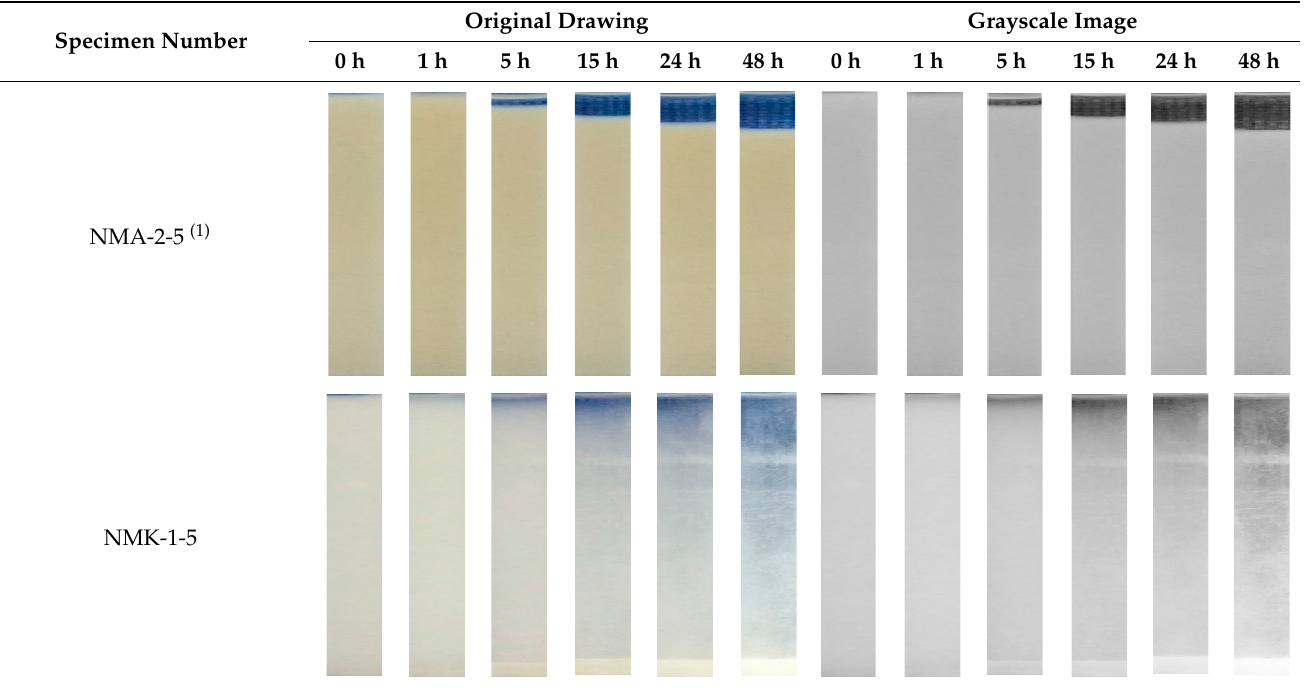
Table 4. The settlement diagram of nanoclay suspension.